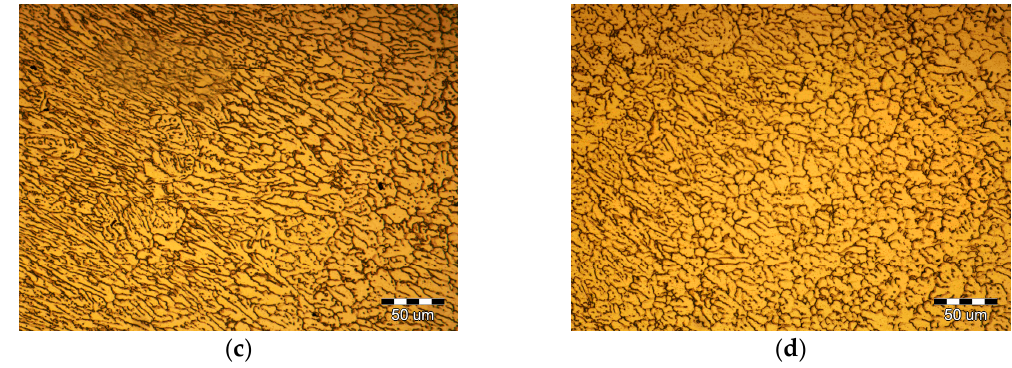
Figure 9. Effect of pulse frequency f H on the PCALW weld microstructure for: ( a ) f H = 5/3 Hz; ( b ) f H = 10/3 Hz; ( c ) f H = 20/3 Hz; and ( d ) f H = 100/3 Hz.